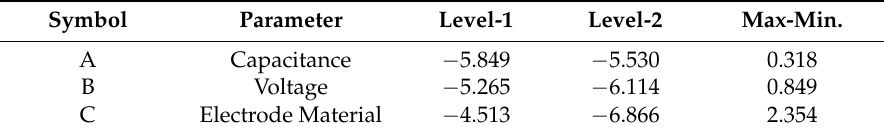
Table 11. Response table for signal-to-noise ratios and Grey relational